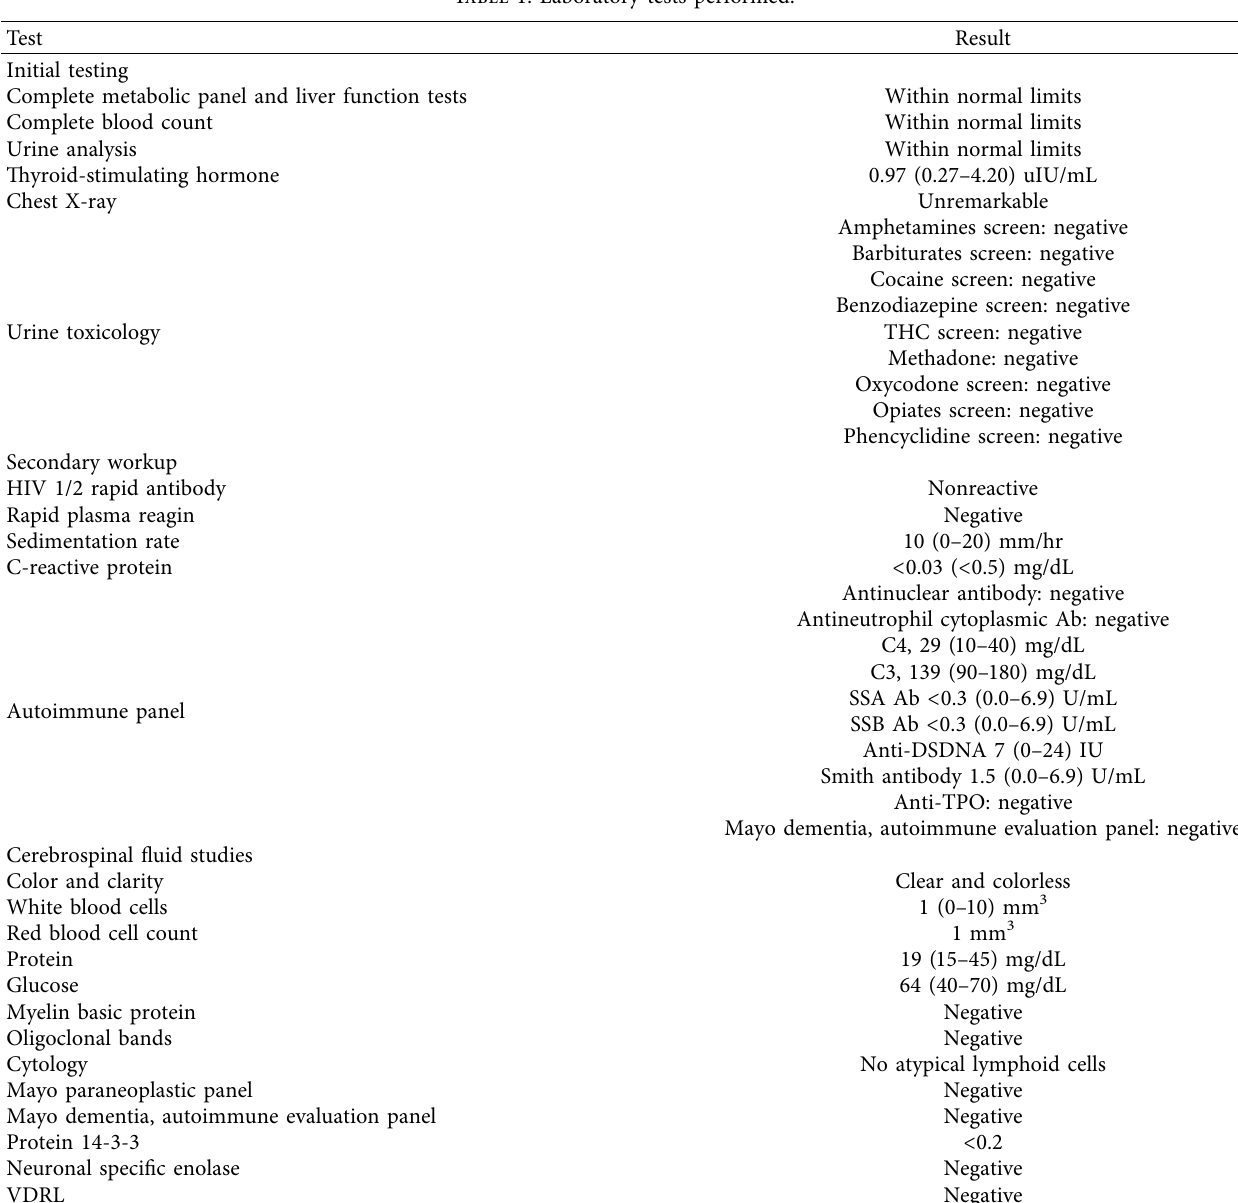
Table 1: Laboratory tests